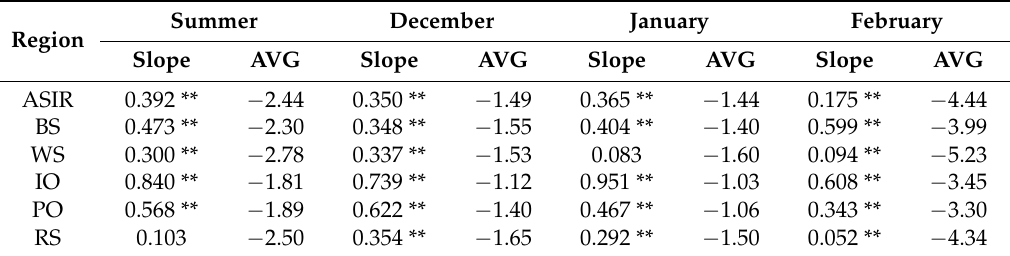
Table 5. As in Table 2, but for SST. The units of slope and AVG are ‘°C per decade’ and ‘°C’,